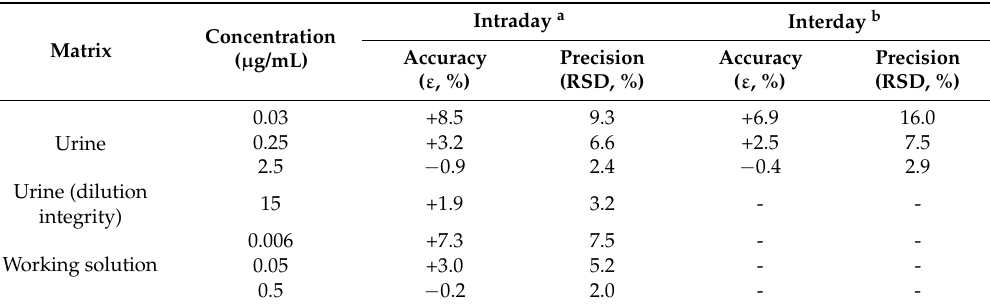
Table 1. Intraday and interday accuracy and precision.